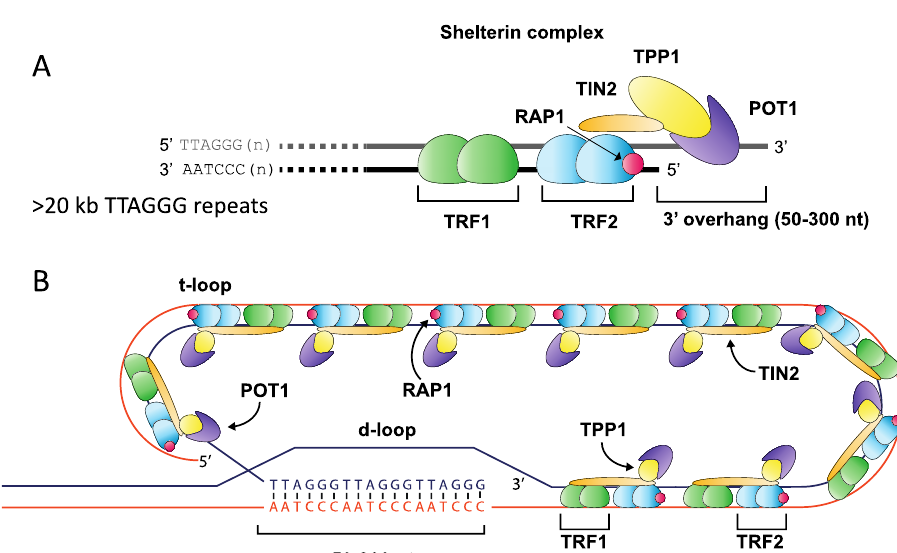
Figure 1. Overview of telomere structure. The terminal ends of mammalian chromosomes consist of an array of (TTAGGG) n repeats ending with a 3′ overhang of between 50 and 300 nt in length ( A ). This array is bound by many protein components including members of the shelterin complex, which anchors to the repeat array through Telomere Repeat binding Factors 1 & 2 (TRF1 and TRF2), binding repeats as a homodimer, and forming a complex with TIN2 (TRF1-interacting factor), RAP1 (Repressor Activator Protein 1), TPP1 and POT1 (Protection of Telomere 1) ( A ). The repeat array folds into a higher-order t-loop structure where the 3′ overhang displaces a portion of the forward strand to create a d-loop, thereby sequestering the free chromosome end from the DNA repair machinery ( B ).